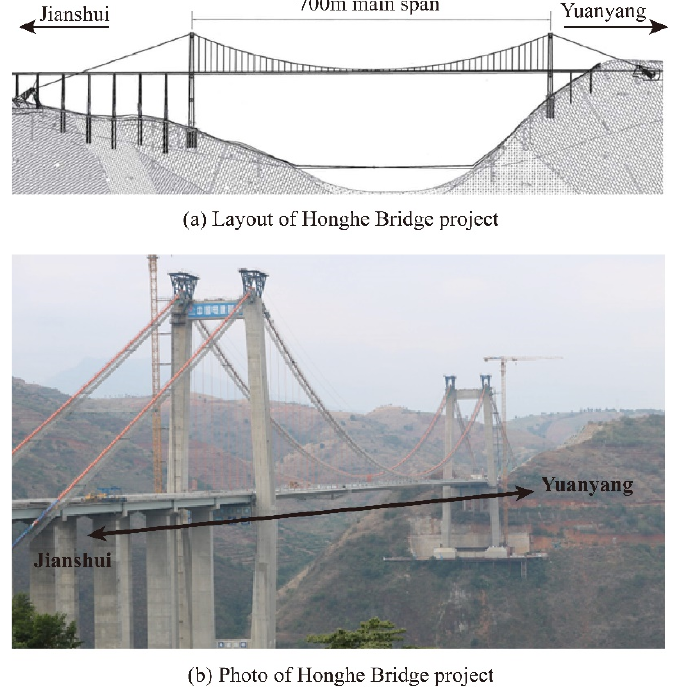
Figure 1. The layout of Honghe Bridge project.